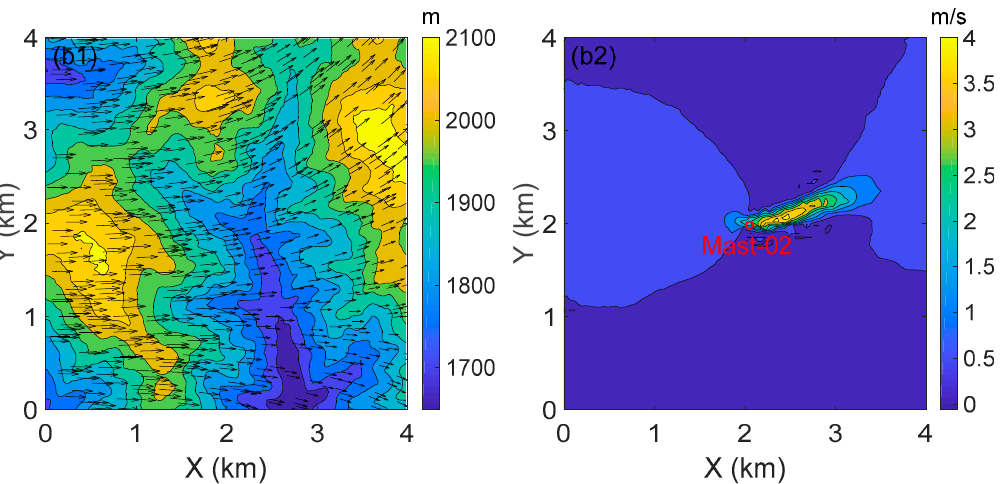
Figure 16. The relationship between wind direction and the impact area of data assimilation: ( a1 , a2 ) wind vectors (left) and the difference in wind velocity between the CFD model simulation with and without assimilation (right), at 400 m altitude, on 22 May 2018 at 16:00 UTC; ( b1 , b2 ) wind vectors (left) and difference in wind velocity between the CFD model simulation with and without assimilation (right), at 400 m altitude, on 23 May 2018 at 13:00 UTC.